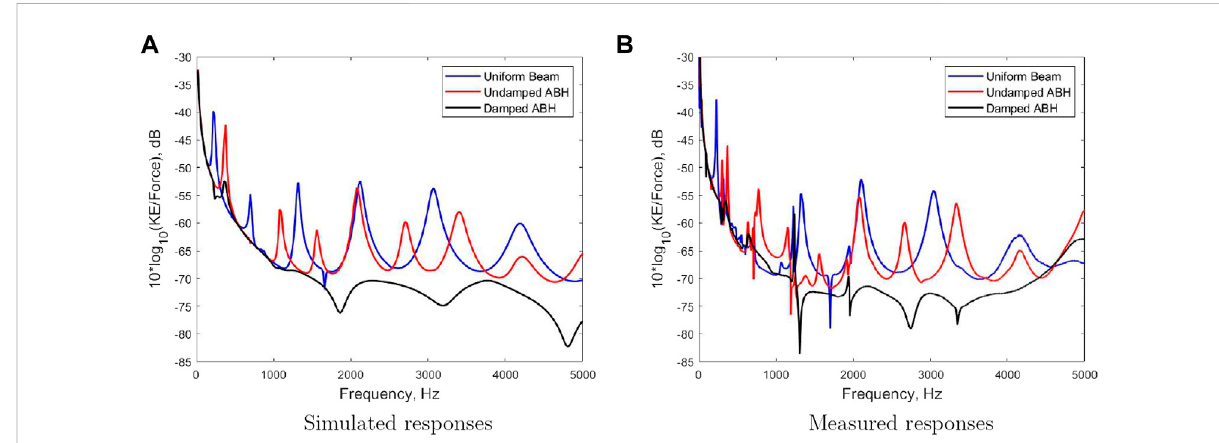
FIGURE 4 Kinetic energy normalised to the force input over frequency for the simulated (A) and measured (B) responses corresponding to the uniform beam (blue), undamped ABH (red) and damped ABH